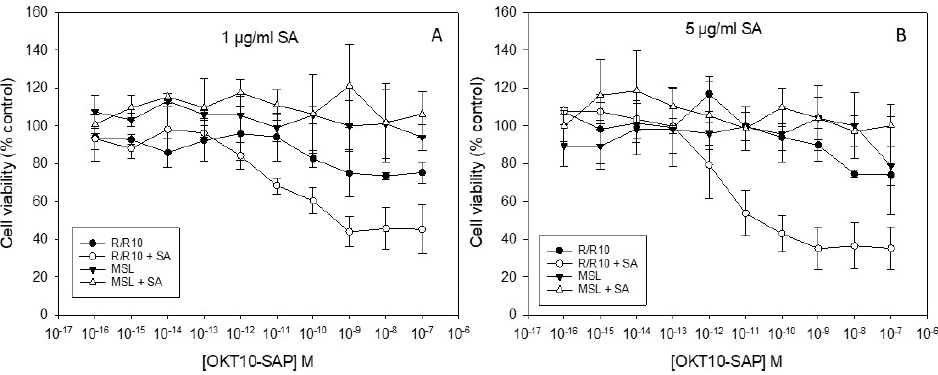
Figure 3. Lipid depletion of Daudi cells abrogates the SA augmentation of OKT10-SAP cytotoxicity. Dose–response curves obtained by XTT assay for lipid deprived Daudi cells in the presence ( ∆ ) or absence ( ▼ ) of 1 ( A ) or 5 ( B ) µg/mL SA exposed to increasing concentrations of OKT10-SAP compared to the mock-treated Daudi control cells in the absence ( ● ) or presence ( ○ ) of SA. Samples were blank